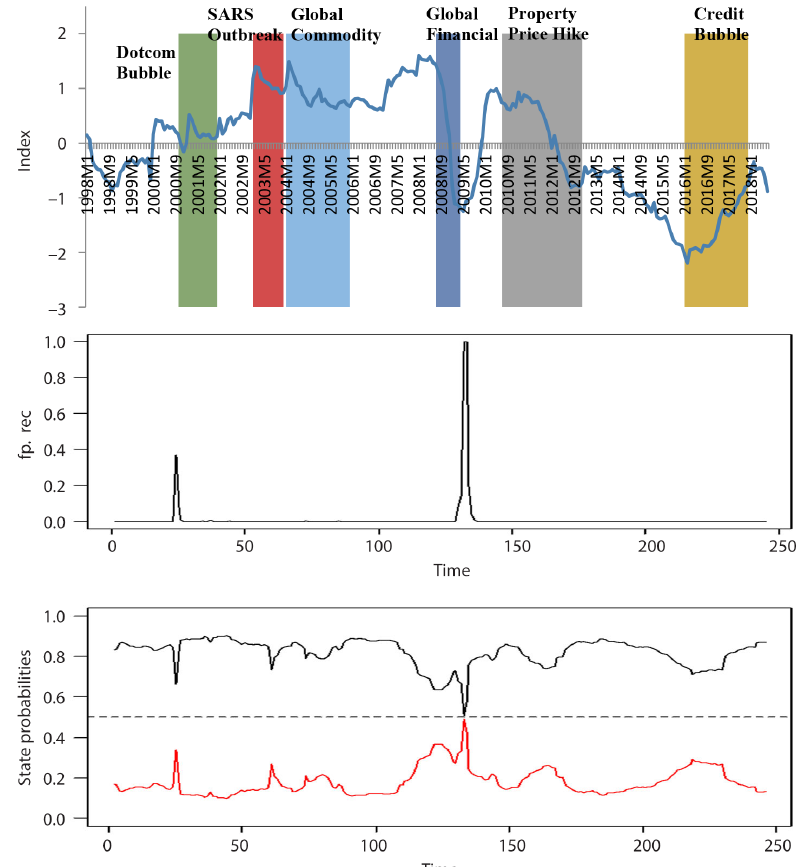
Figure 3. Markov switching model for the